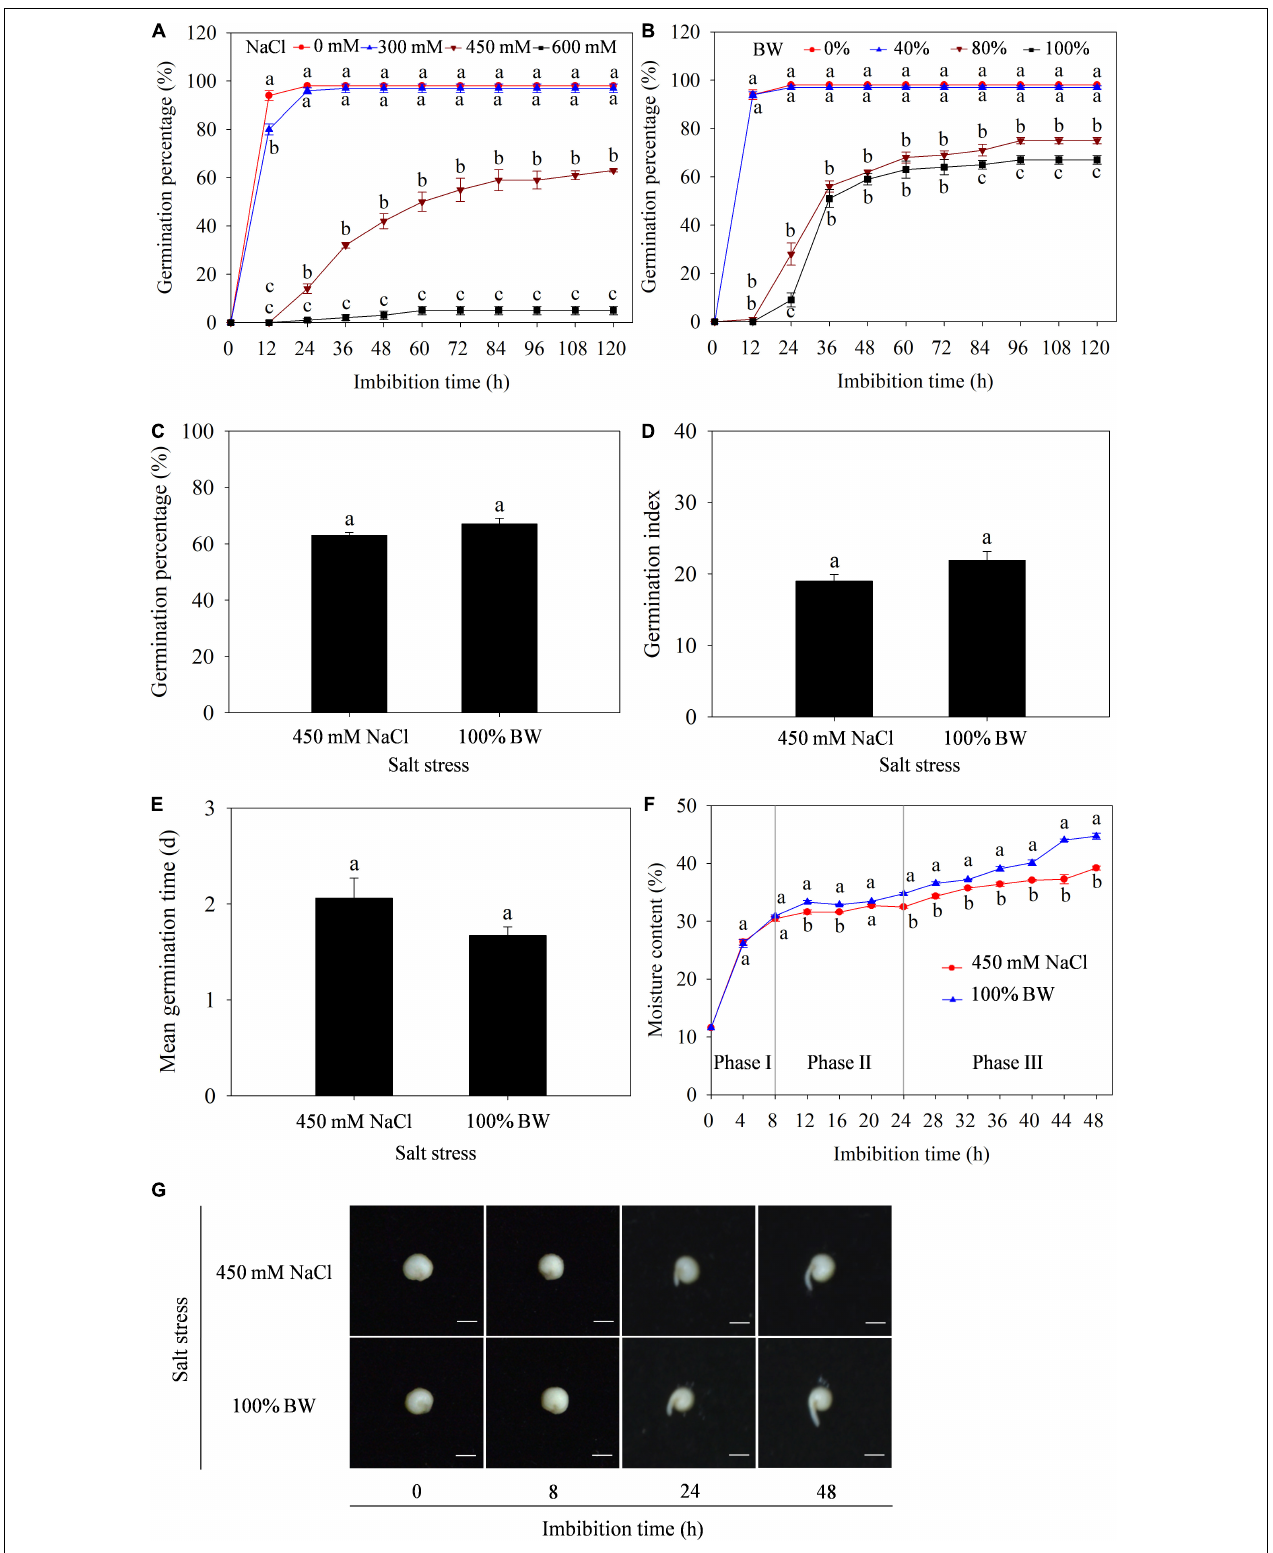
FIGURE 1 | Effects of salt stress on germination of quinoa seeds. Germination percentage under different concentrations of (A) NaCl (0, 300, 450, and 600 mM) and